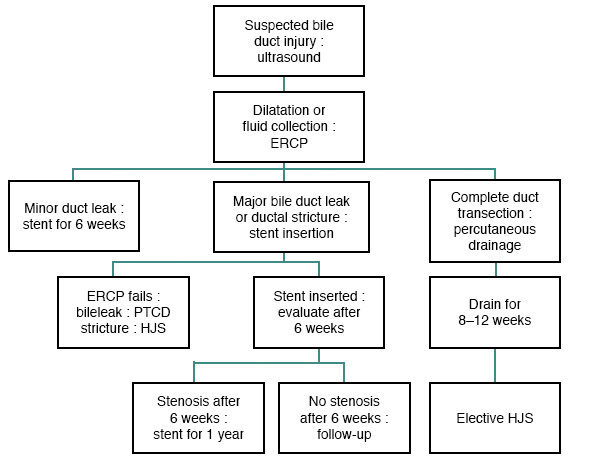
Suggested flow diagram for patients with suspected bile duct injury after laparoscopic cholecystectomy [3].